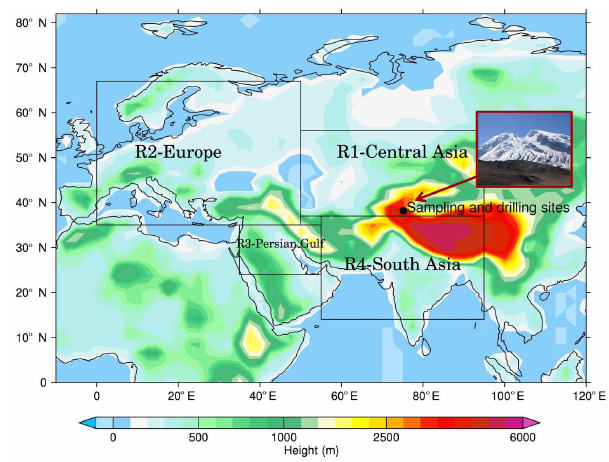
Figure 1. The Muztagh Ata measurement site (indicated by the dot), and the surrounding BC source areas (R1 – Central Asia region; R2 – European region; R3 – Persian Gulf region; and R4 – South Asia